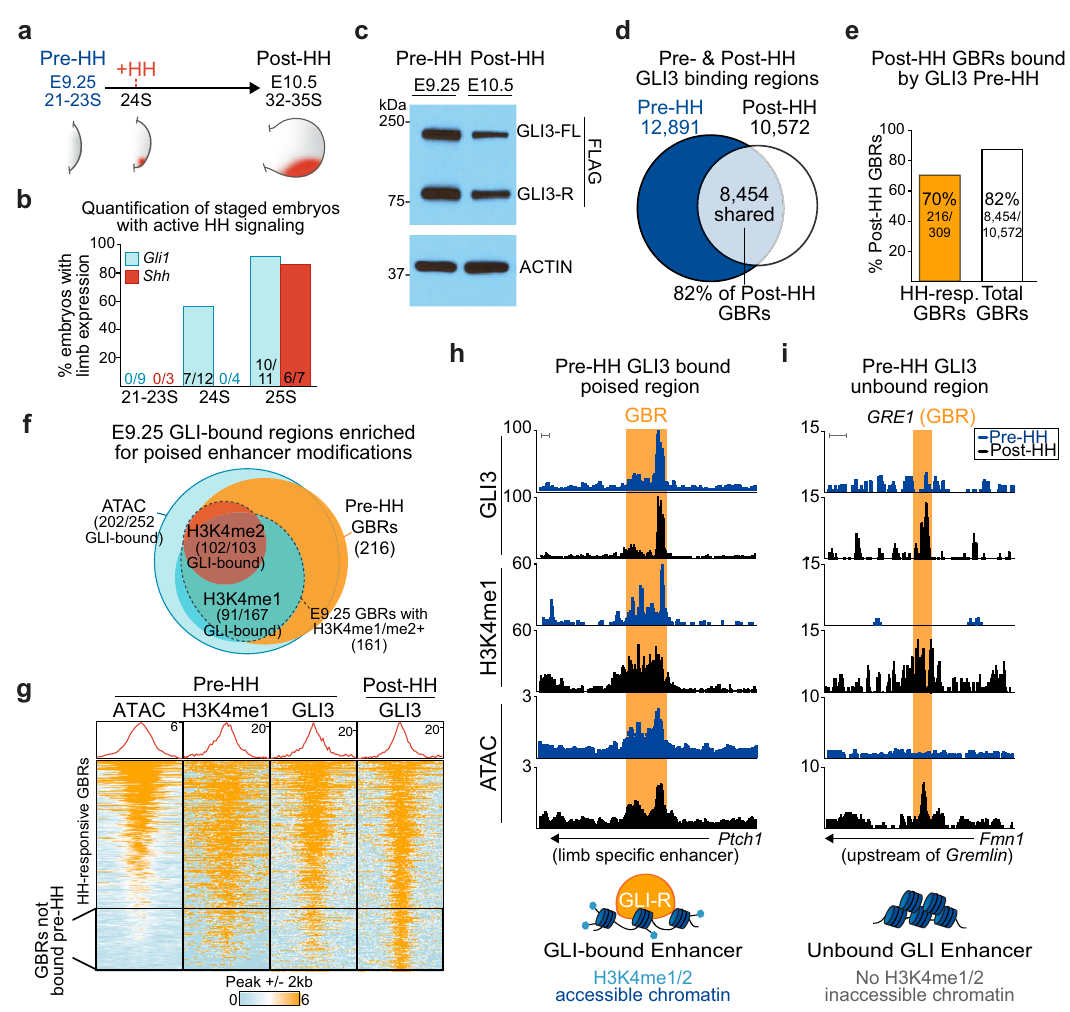
Fig. 1 GLl3 binds to poised, accessible chromatin prior to HH signaling. a Schematic for HH induction timeline during limb development. b Quanti fi cation of 21 – 25 S embryos with expression of Gli1 and Shh assayed by in situ hybridization. c Representative western blot ( n = 3) of endogenous GLl3 FLAG protein in the limb bud pre-(21 – 23 S) and post-HH signaling (32 – 35 S). d Venn diagram of all pre- and post-HH identi fi ed GLl3 CUT&RUN called peaks. e Percentage of E10.5 GLl3-bound regions also bound at E9.25, before HH signaling, for all E10.5 identi fi ed GBRs and E10.5 HH-responsive GBRs. f Venn diagram of HH-responsive GBRs enriched for poised enhancer marks and bound by GLl3 at E9.25. Poised enhancer modi fi cations identi fi ed by H3K4me1 CUT&Tag ( n = 3), H3K4me2 ChlP-seq ( n = 2), ATAC-seq ( n = 2). g Heatmap of GLl3 enrichment pre and post-HH signaling and enrichment of poised enhancer marks pre-HH signaling. Many regions lacking GLl3 also lack enrichment of poised marks. h Example of a HH-responsive GBR (orange shading) that is poised, accessible, and bound by GLl3 prior to HH signaling at a limb-speci fi c Ptch1 enhancer 26 . i Example of a validated HH-responsive GBR GRE1, that regulates the GLl3 target Gremlin 27 , that is inaccessible, lacks H3K4me1 and GLl3 binding at E9.25. Scale bars = 1 kb. Source data are provided as a Source Data fi